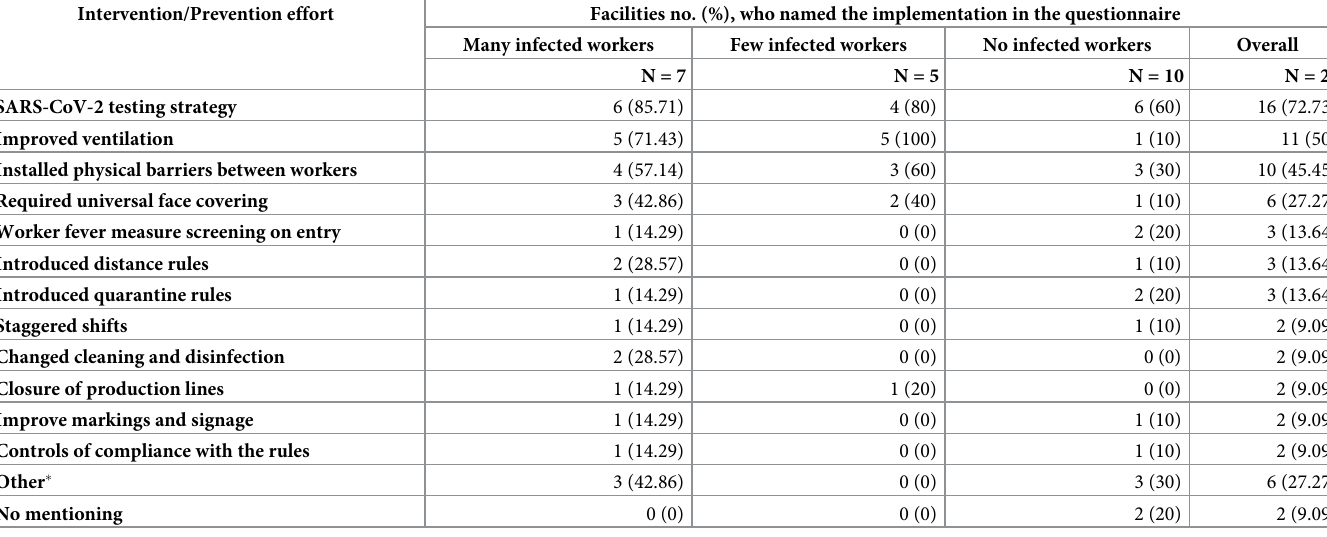
Table 1. Interventions and prevention efforts implemented by facilities in response to COVID-19 among workers or planned if there would be a case in 22 meat and poultry processing facilities—June–September 2020.